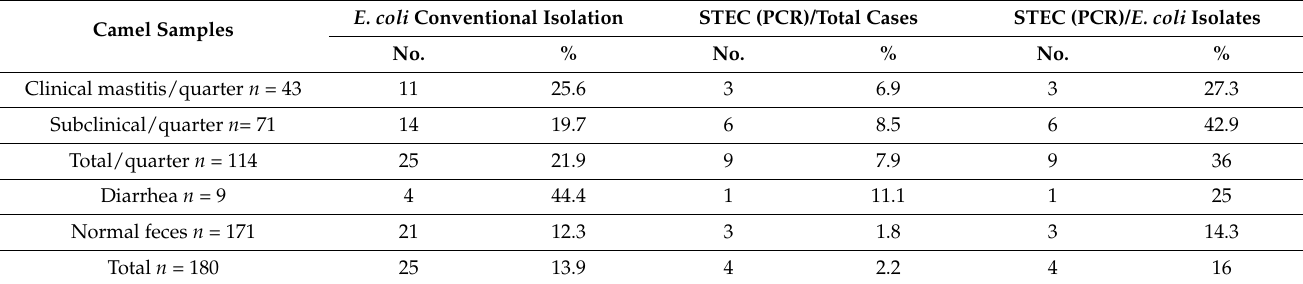
Table 3. Isolation of E. coli from milk samples/quarter and fecal samples of the examined she-camels. Camel